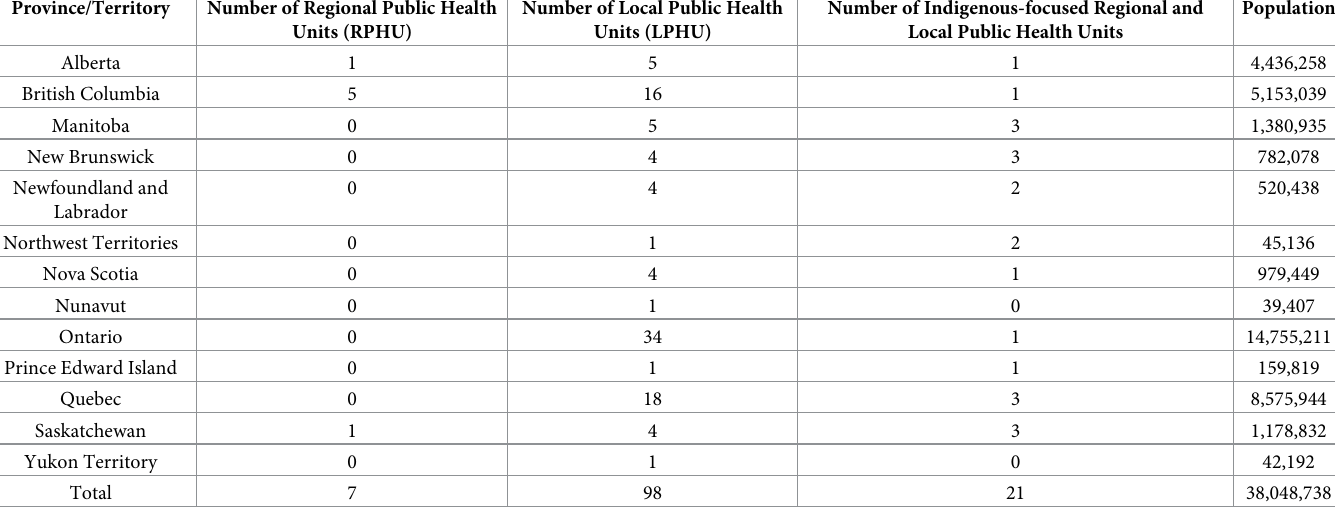
Table 1. Number of regional public health units (RPHU) and local public health units (LPHU) in Canada. Province/Territory Number of Regional Public Health Number of Local Public Health Number of Indigenous-focused Regional and Units (RPHU) Units (LPHU) Local Public Health Units